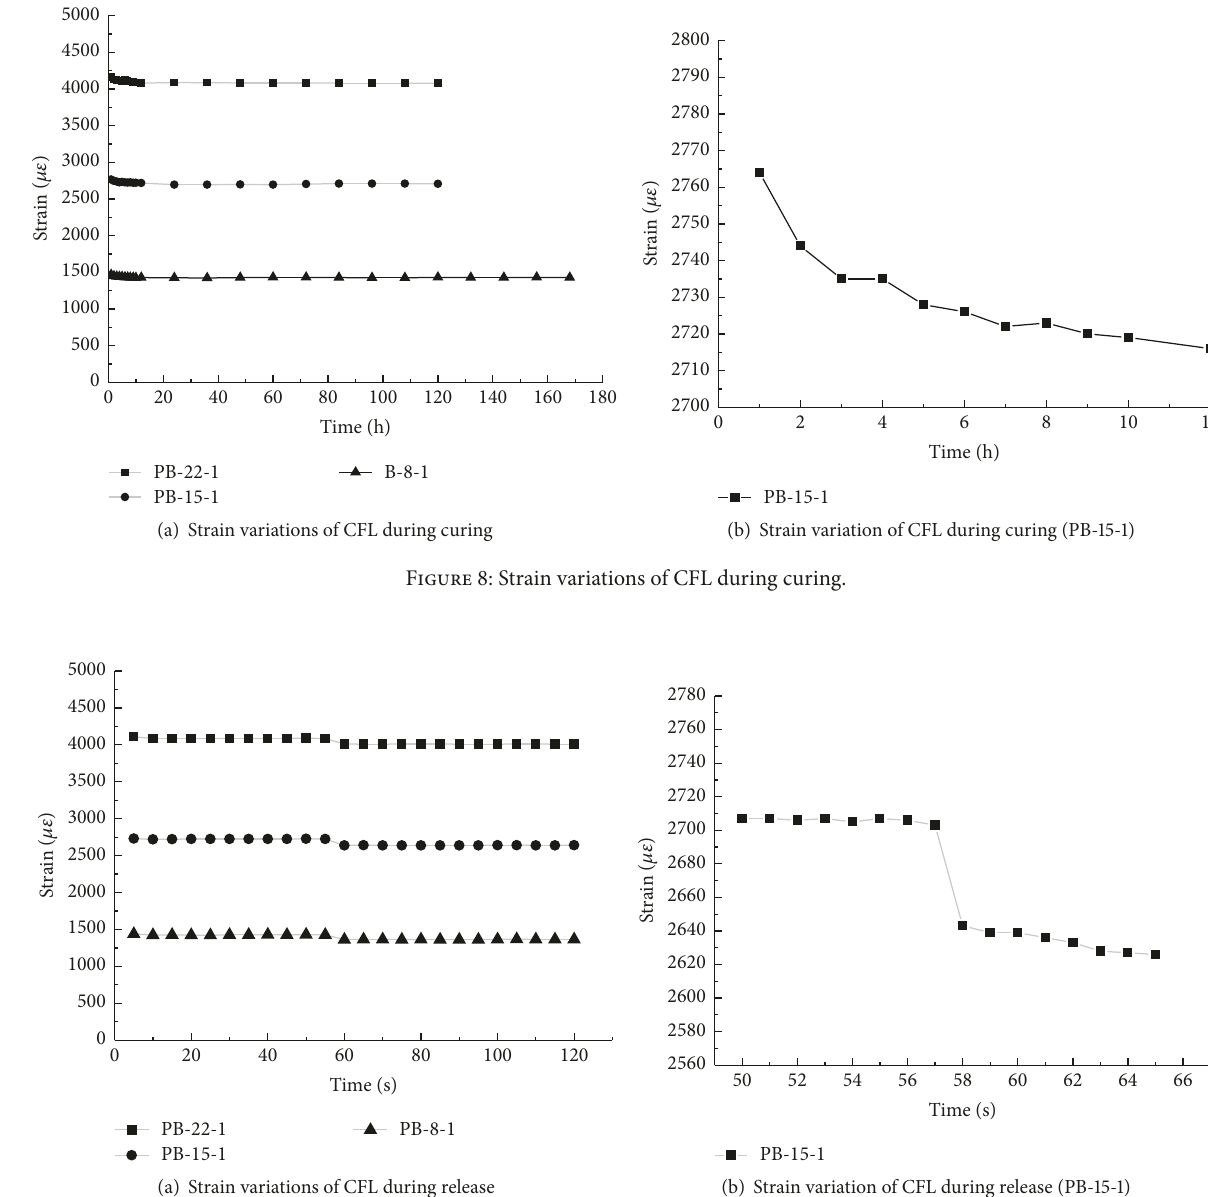
Figure 9: Strain variations of CFL during